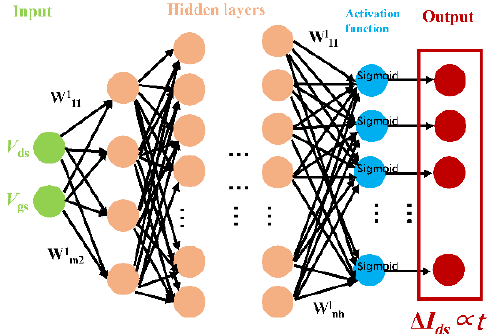
Figure 8. The ANN algorithm.